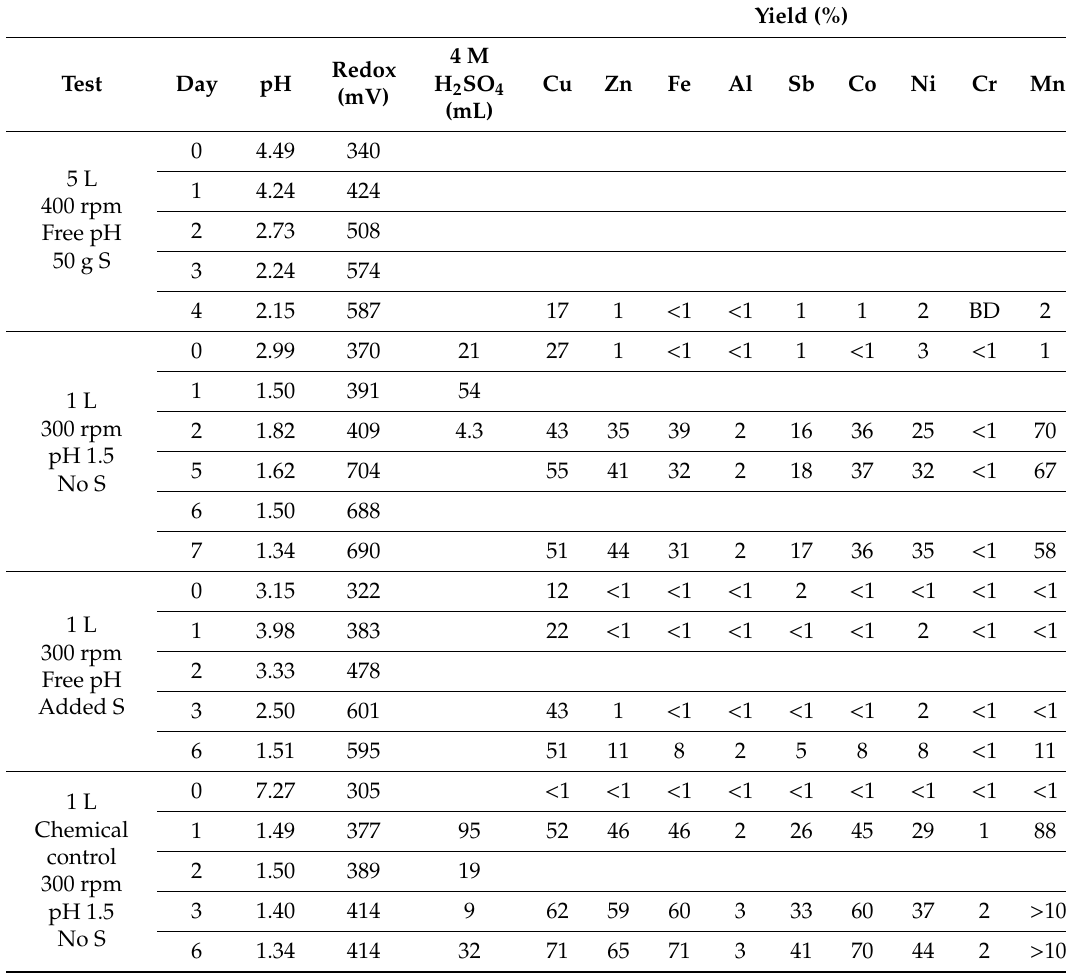
Table 7. Metal yields (%) during bioleaching of the copper slag in the reactors (pulp density 10%, temperature 32 ◦ C, and a blade impeller). Below detection limit